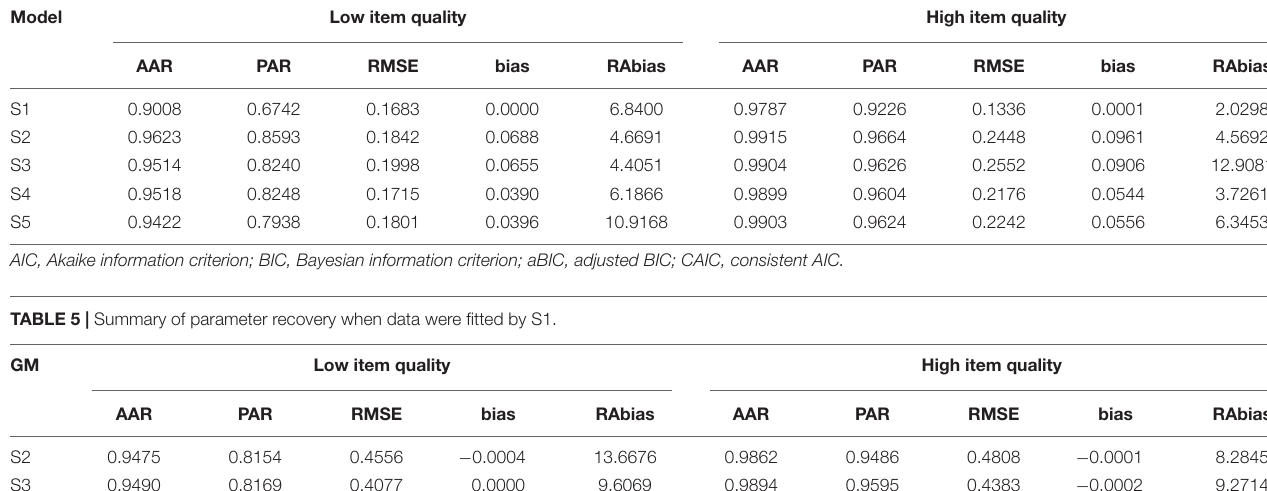
TABLE 4 | Summary of parameter recovery when CM = GM. Model